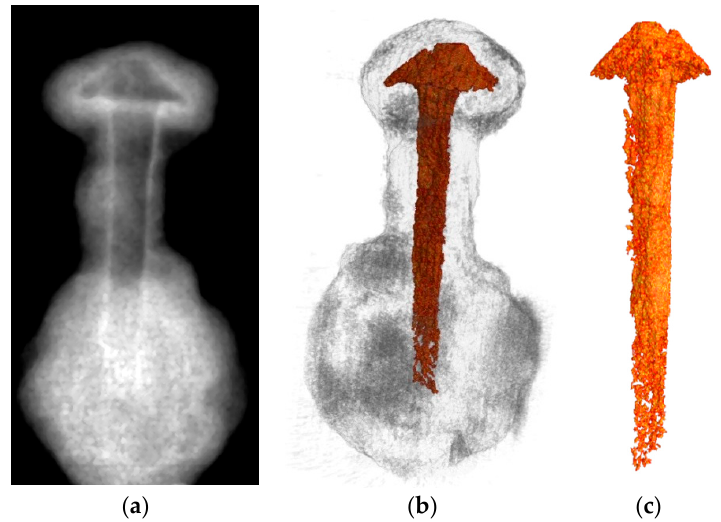
Figure 4. ( a ) The neutron radiography image of the fragment of the bireme remains; the background is black; ( b ) the virtual 3D model of the fragment of the bireme remains, the copper remains are labeled in a dark yellow color, the corrosion component is grey; the corrosion components are made more transparent for clarity; ( c ) the separated 3D volume of the metal inclusion in the bireme fragment.